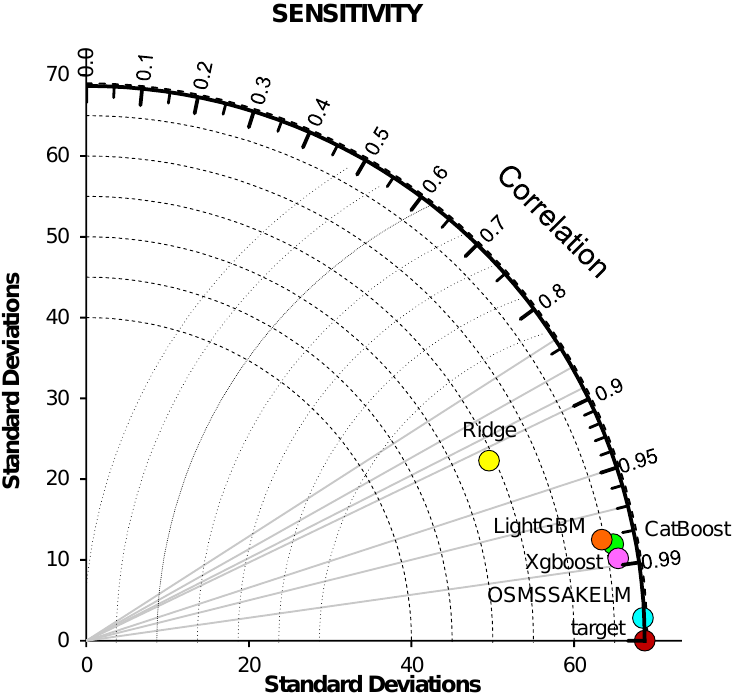
Figure 22. Taylor plot of the proposed model versus other regression methods for the training phase.